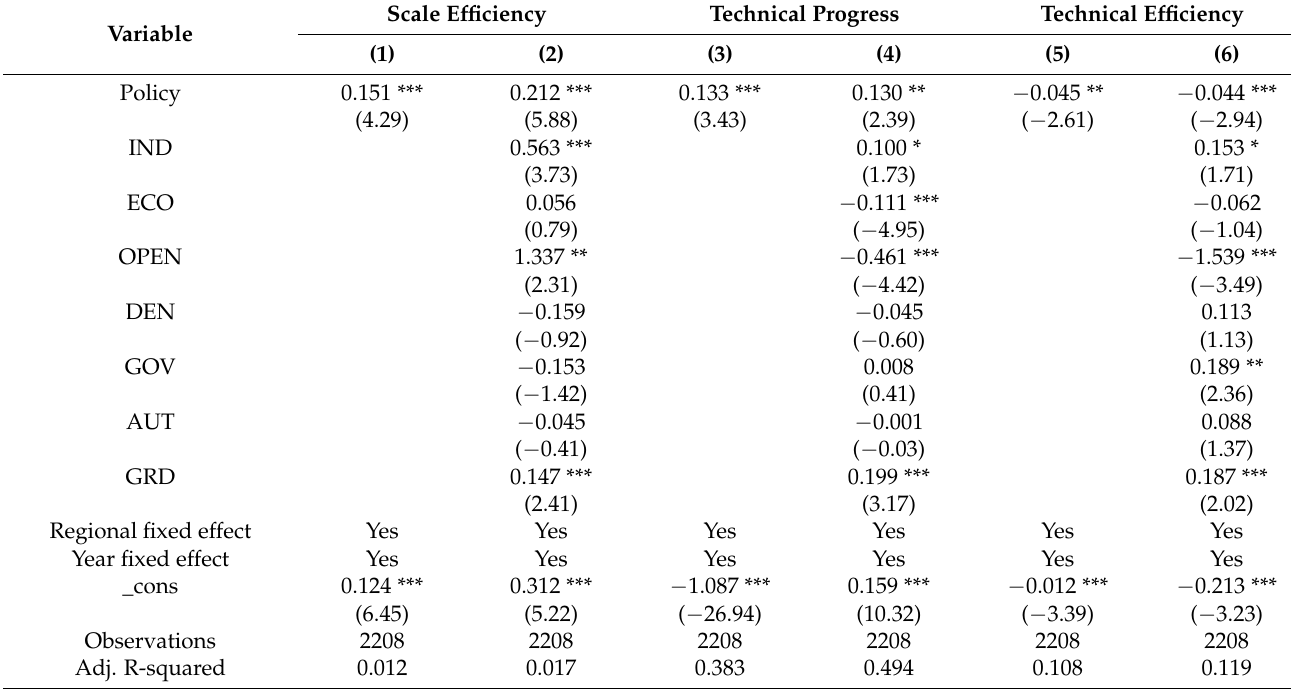
Table 4. Effects of low-carbon city construction (LCC) on the components of the total factor productivity (TFP).